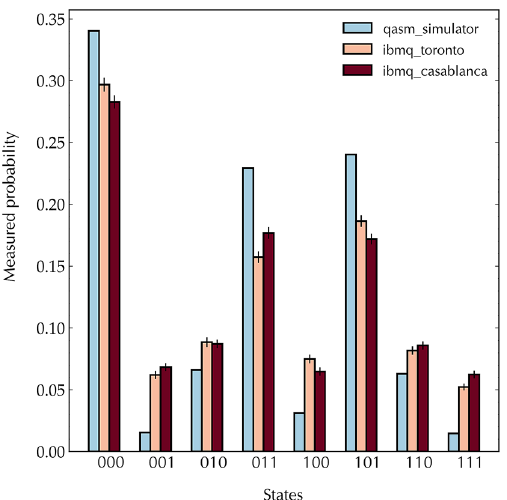
4 . On each processor, 21 and a = =